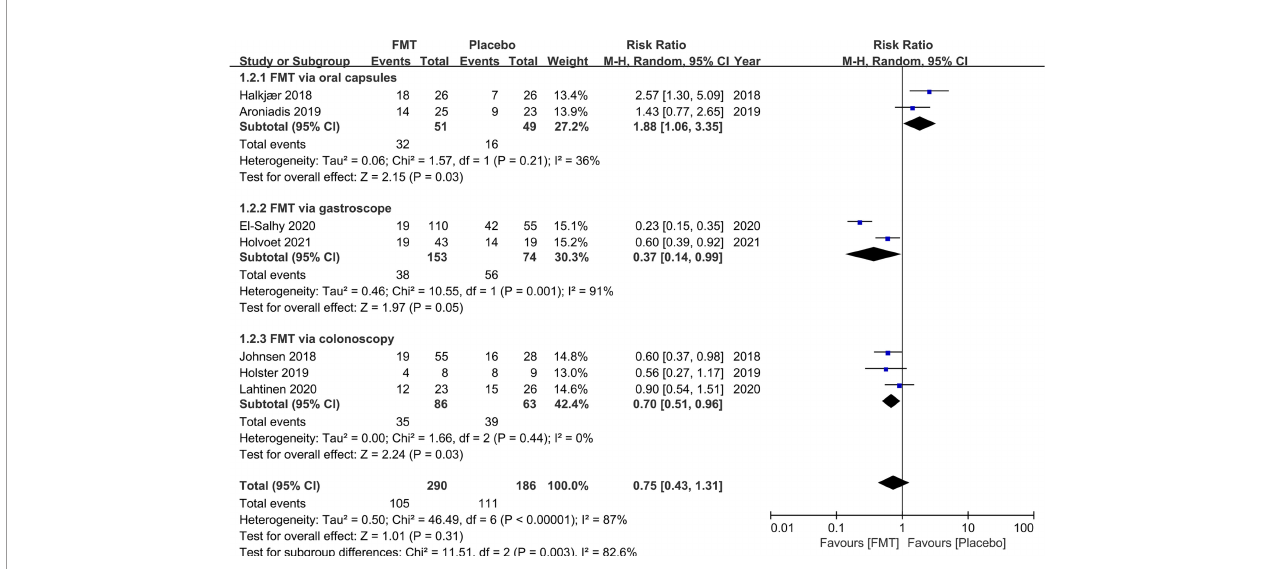
FIGURE 2 | Forest plot of all included RCTs of global symptom not improving in comparison between FMT and placebo in irritable bowel syndrome at 12